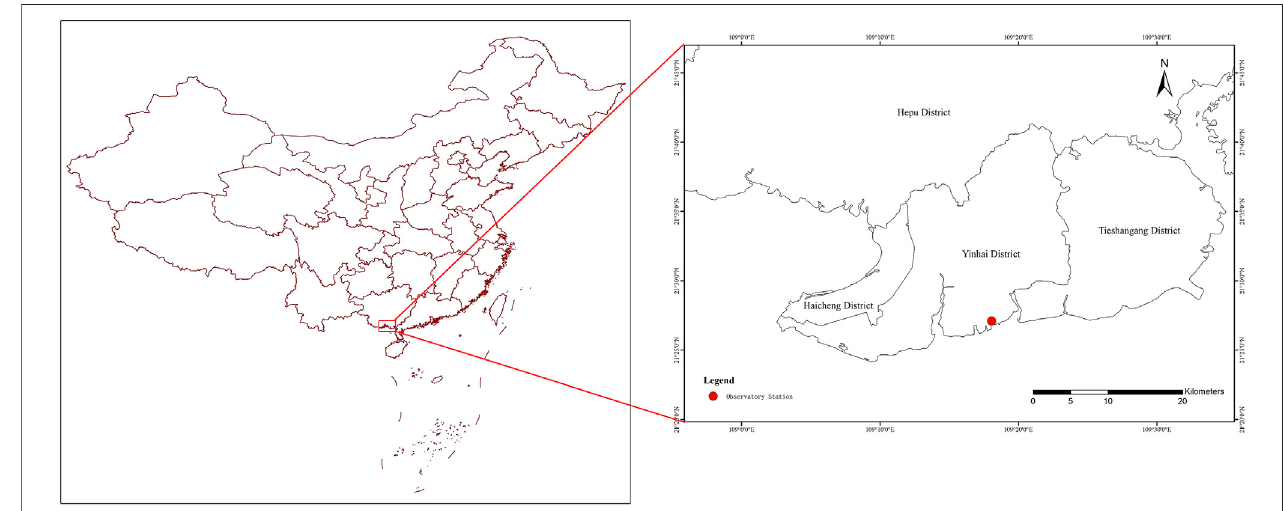
FIGURE 1 | The geographical location of the ecological